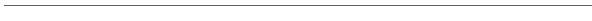
TABLE 2 | Means and credibility intervals of 95% (Inferior and Superior) for marginal posterior distributions estimated by a beta-regression INLA model to assess the effect of feeding habit (FeedHab; as generalist, specialist, and fi lter- feeding) and the interaction of FeedHab with the diel period (DielPer) (i.e., day and night) on the proportion of time spent in surface ( ≤ 10 m in depth) waters by pelagic elasmobranchs. Parameter Mean Intercept